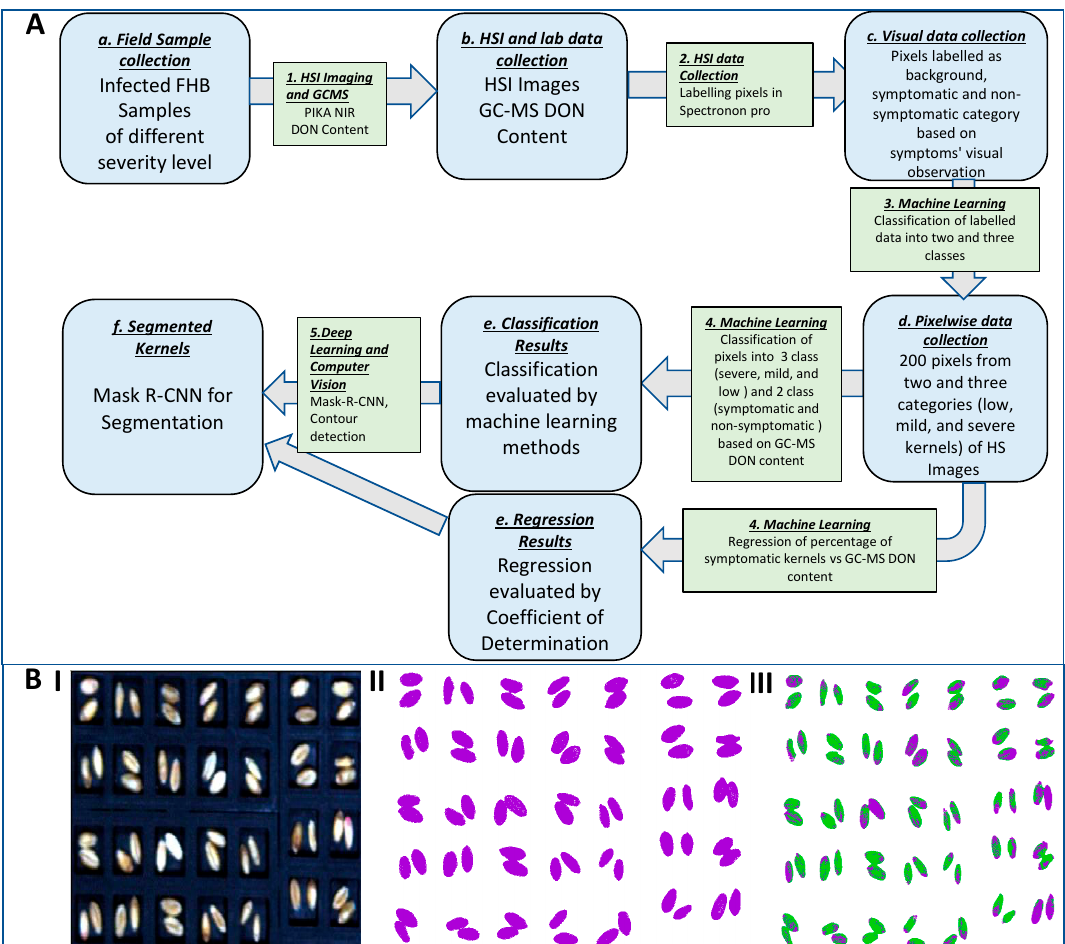
Figure 1. ( A ) Data analysis pipeline for the wavelength selection to classify wheat kernels as symptomatic and non-symptomatic for Fusarium graminearum. ( B ) ( I ) RGB representation of HSI. ( II ) Classi fi cation of HSI into foreground (purple) and background (white) pixels. ( III ) Classi fi cation of HSI into symptomatic (purple), non-symptomatic (green), and background (white) pixels.